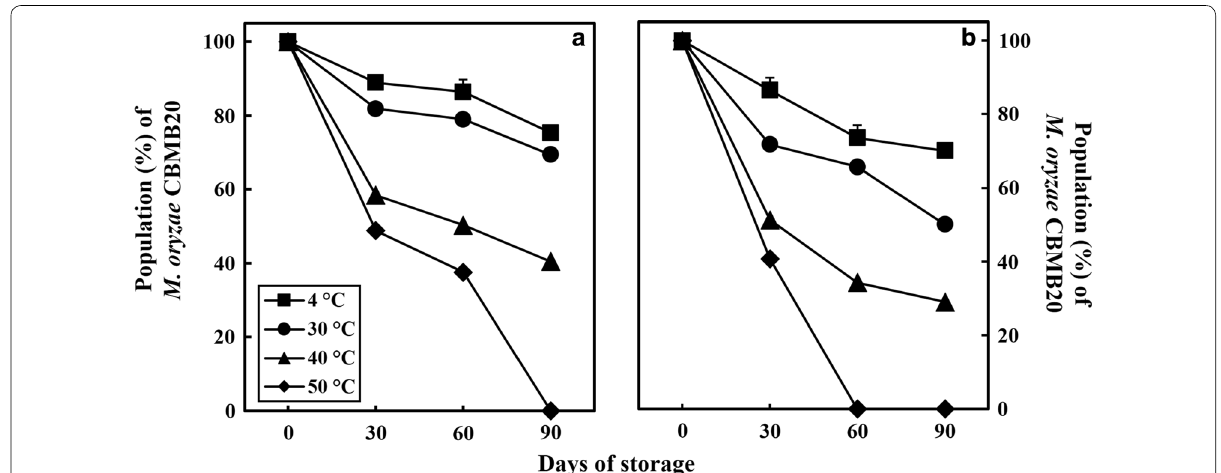
Fig. 2 The impact of a range of temperature on the survival of a aggregated and b non-aggregated cells of M. oryzae CBMB20. All data represents mean SE of three replicates and differences between means analyzed using DMRT test ( P ±